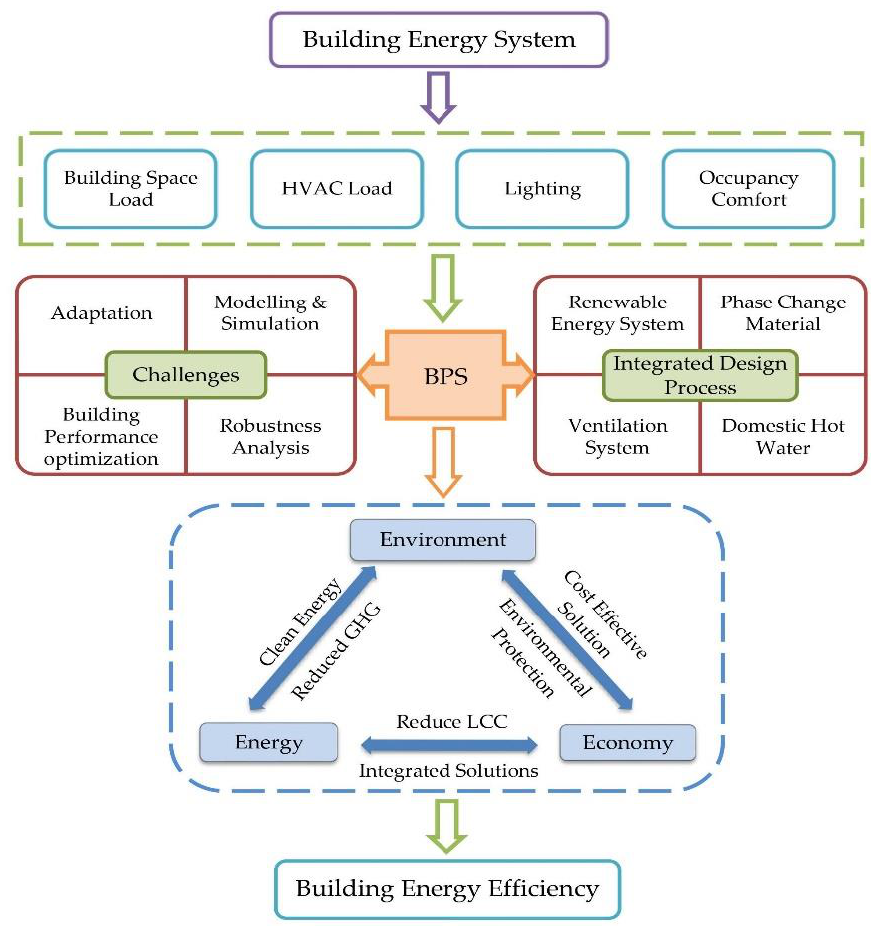
Figure 1. A Morphology Chart.